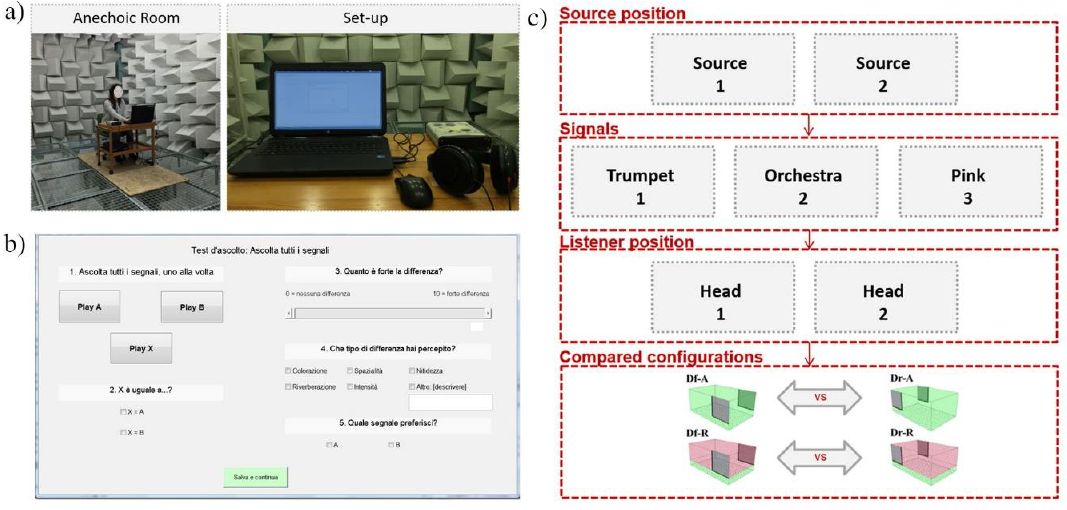
Figure 3. ( a ) Listening test anechoic room set-up, ( b ) user-interface in Italian, and ( c ) listening test scheme.